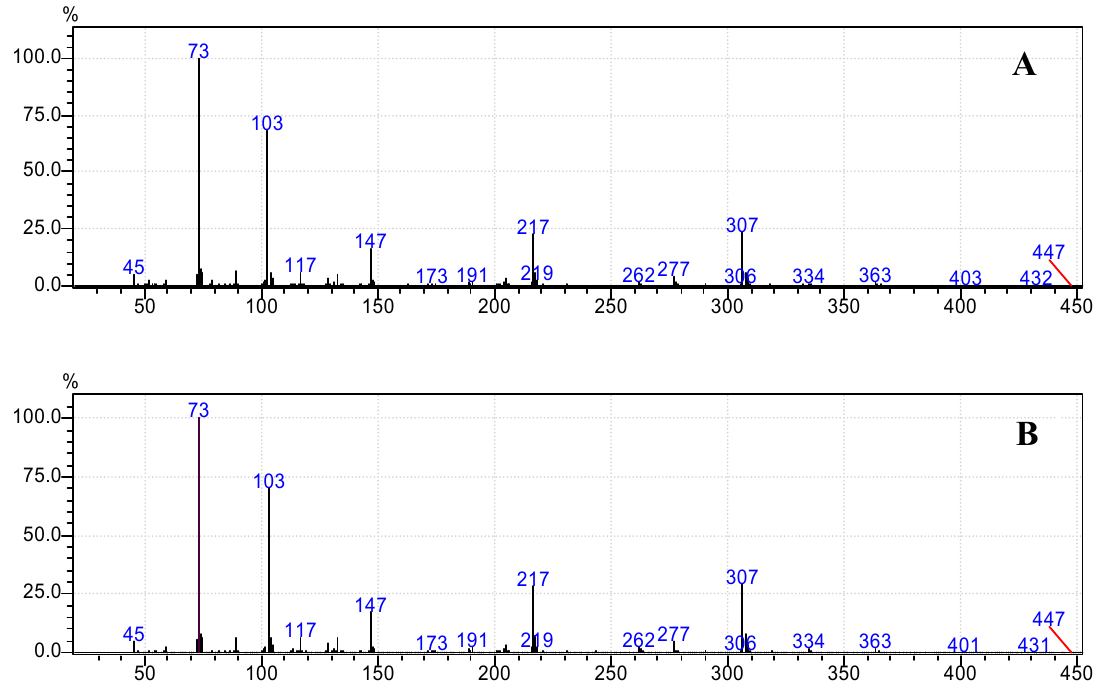
Figure 7. Mass spectrum at a retention time of 3.905 min. ( A ) Standard fructose; ( B ) Date juice.